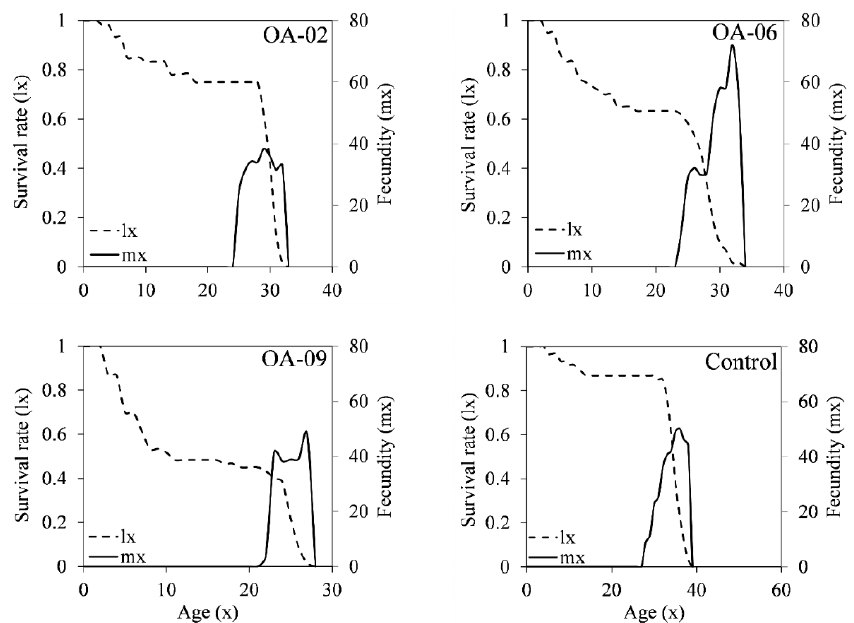
Figure 5. Age-specific survival ( l x ) and age-specific fecundity ( m x ) of Helicoverpa armigera when treated with OA-02, OA-06 and OA-09 compounds.